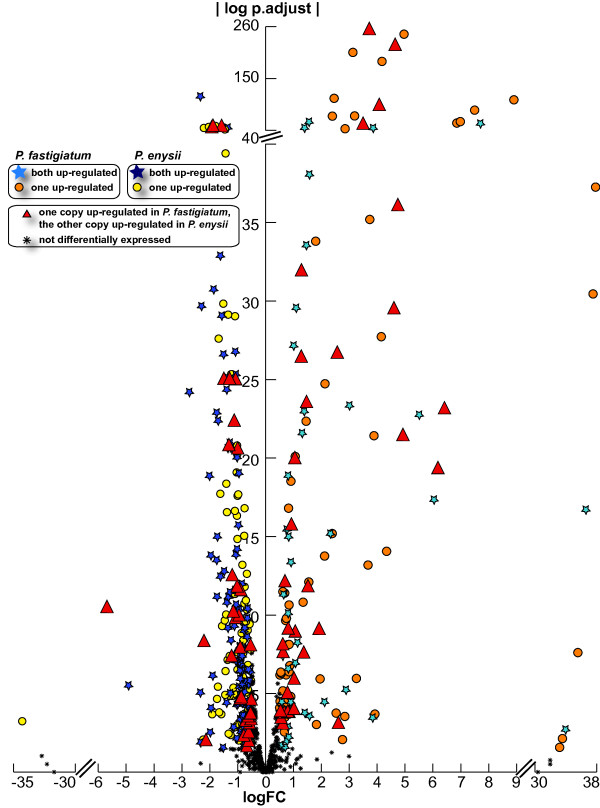
Volcano plot depicting differentially expressed homeologous gene copies obtained using P. fastigiatum full-lengths ESTs as a reference for tag mapping. With gene loci for which gene expression of individual homeologous copies could be studied we identified 245 genes up-regulated in P. enysii and 136 genes up-regulated in P. fastigiatum. 392 such loci were not differentially expressed between species (black cross). Among the up-regulated genes, six different patterns were detected. In 111 cases all copies of one locus were up-regulated in P. enysii (dark blue stars); in 38 cases both copies were up-regulated in P. fastigiatum (light blue stars); for 101 and 65 sequences, one copy was up-regulated in P. enysii (yellow circles) and P. fastigiatum (orange circles), respectively, whereas the other copy was not differentially expressed and in 66 cases one copy was up-regulated in one species while the other was up-regulated in the other (red triangles). Log fold ratios >30 and < −30 indicate genes with zero tags in either of both species whereas log fold ratios between −10 and 10 indicate genes with tags present in both species but differing in abundance.